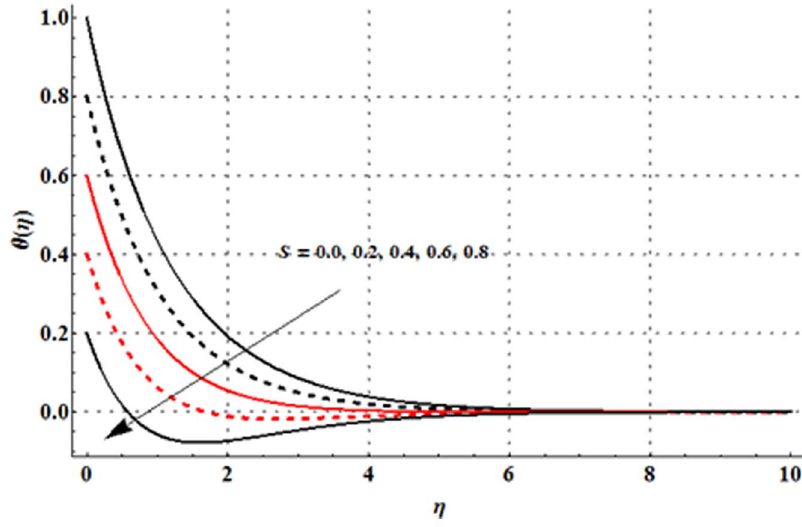
Figure 14. Influence of S on the temperature profile h ( g ) when M ~ 0 : 6, b ~ 0 : 4 ~ Rd , l 1 ~ 0 : 5, l ~ 0 : 3 ~ N , Pr ~ 1 : 2, S (cid:2) ~ 0 : 2 and Sc ~ 1 : 0 :